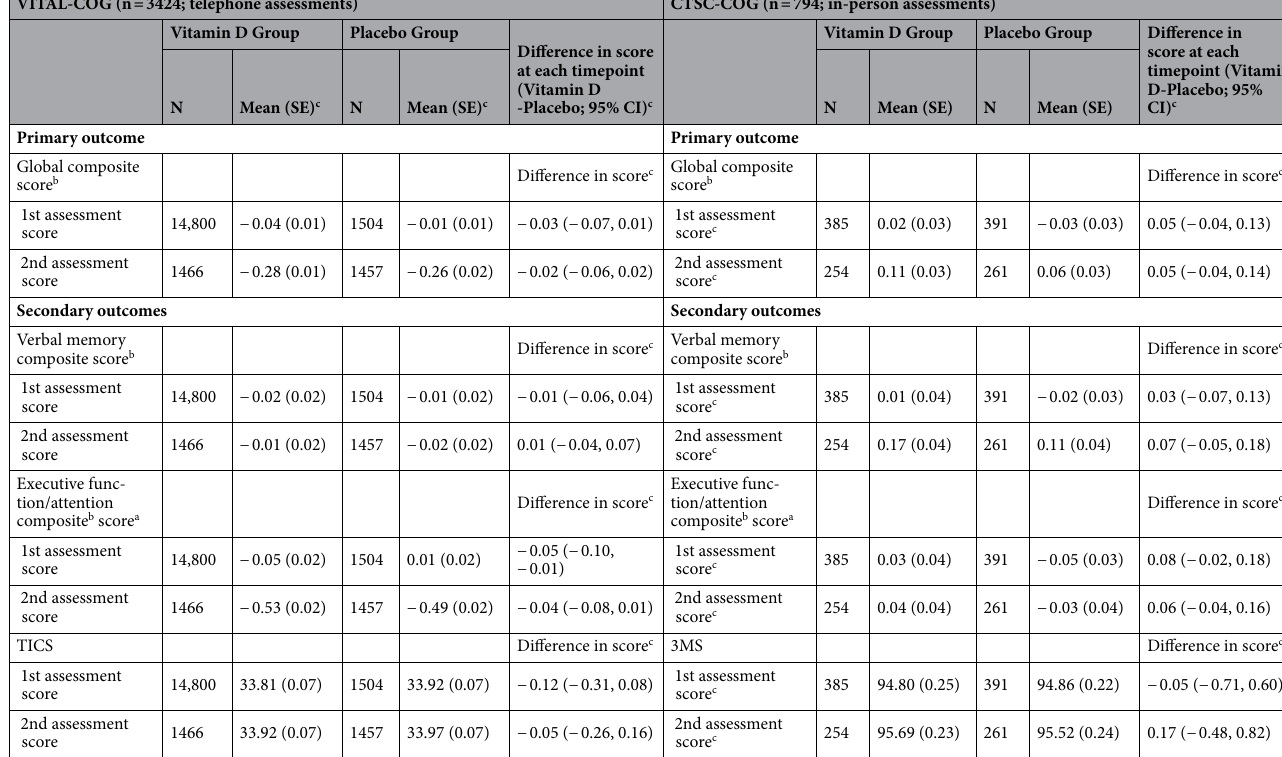
Table 2. Cognitive function at two assessments by Vitamin D supplement assignment, for VITAL-Cog participants aged 60 + years, (n = 3424) assessed by telephone and for CTSC-Cog participants aged 60 + years, (n = 794) assessed in person. 3MS Modified Mini-Mental Status exam (range = 0–100) 33 ; CI confidence interval; CTSC Clinical and Translational Science Collaborative center for VITAL in Boston, MA; TICS Telephone Interview of Cognitive Status (range = 0–41) 37 . a In the VITAL-Cog, 2483 completed both assessments, 501 completed only the baseline, 440 completed only the 2 nd assessment. In the CTSC-Cog, 497 completed both assessments, 279 completed only the baseline and 17 completed only the 2nd assessment. b In the VITAL- Cog: global score is a composite score representing the mean of the z-scores of 8 tests: TICS (range 0–41), immediate and delayed recalls of the East Boston Memory Test, category fluency (animal naming test), delayed recall of the TICS 10-word list, oral trails making test A, oral trails making test B and digit span backwards. Verbal memory score is a composite score representing the mean of the z-scores of 4 tests: the immediate and delayed recalls of both the TICS 10-word list and the East Boston Memory Test. Executive function/attention score is a composite score representing the mean of the z-scores of 4 tests: trails making test A and B, category fluency tests (naming animals), and digit-span backwards. In the CTSC-Cog: the global score is a composite score representing the mean of the z-scores of 9 tests: 3MS, immediate and delayed recalls of the East Boston Memory Test, category fluency tests (naming animals and vegetables), the immediate and delayed recalls of a 10-word list and trail-making tests A and B. Verbal memory score was defined the same way as in VITAL- and standard errors and differences of least squares means and standard errors were derived from univariate